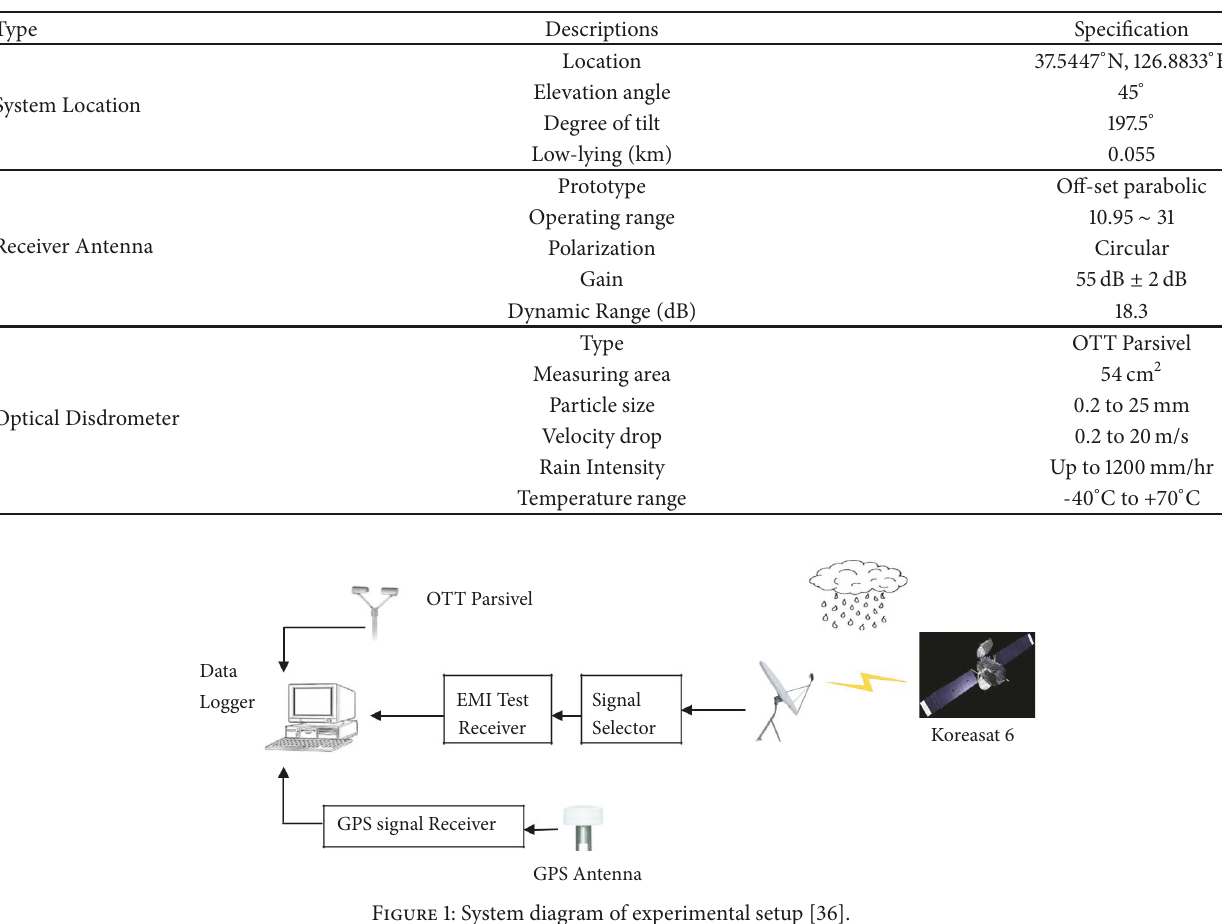
Table 1: Link description for 12.25GHz [36].